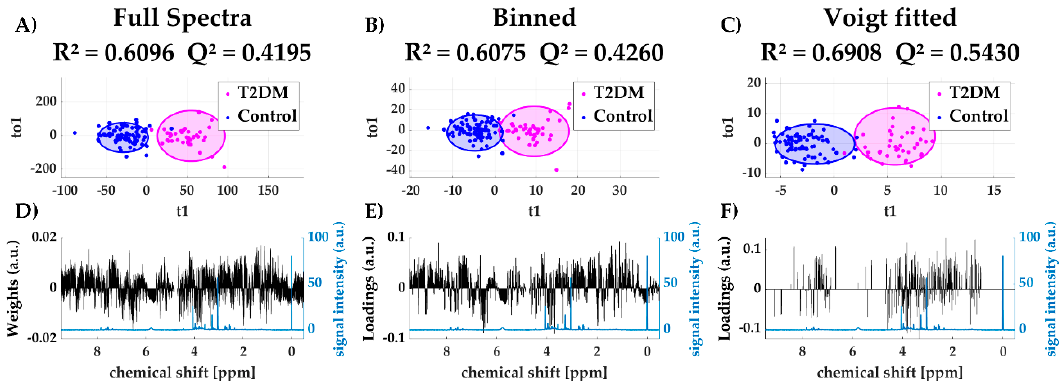
Figure 5. Scores plots of predictive and orthogonal variation using full spectra ( A ), binned data ( B ) and Voigt fitted data ( C ) including 95%-confidence ellipses for each group (Type 2 diabetes mellitus (T2DM) and control); loadings plot for first predictive component for all three methods (black) with reference spectrum (blue) ( D – F ) .